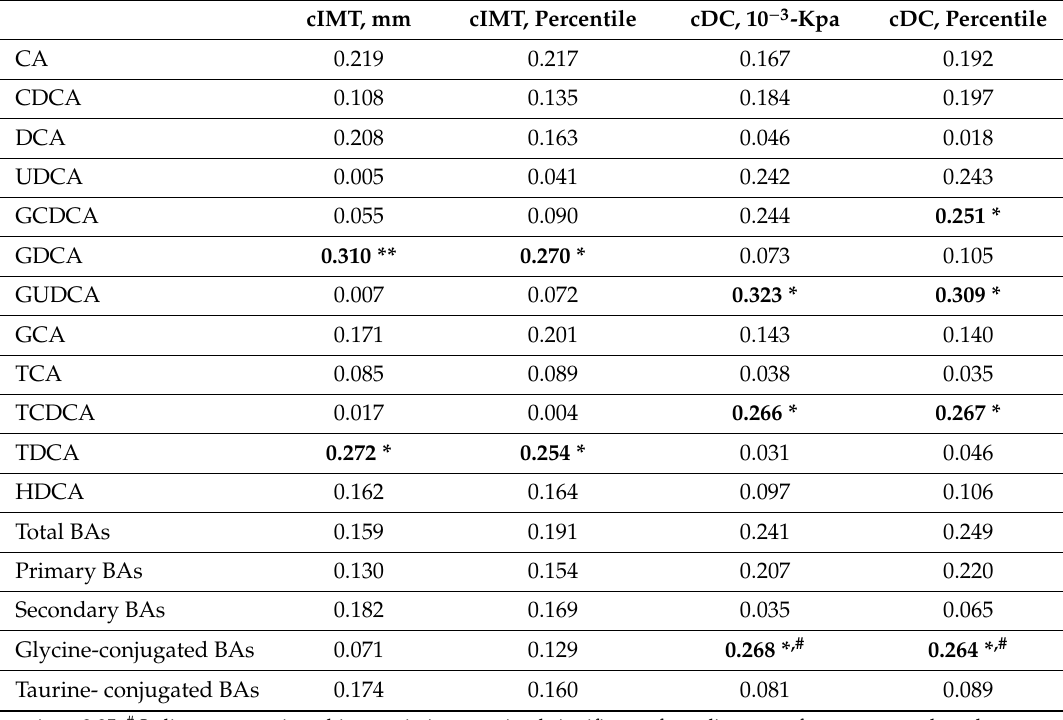
Table 5. Correlations between BAs and markers of subclinical vascular